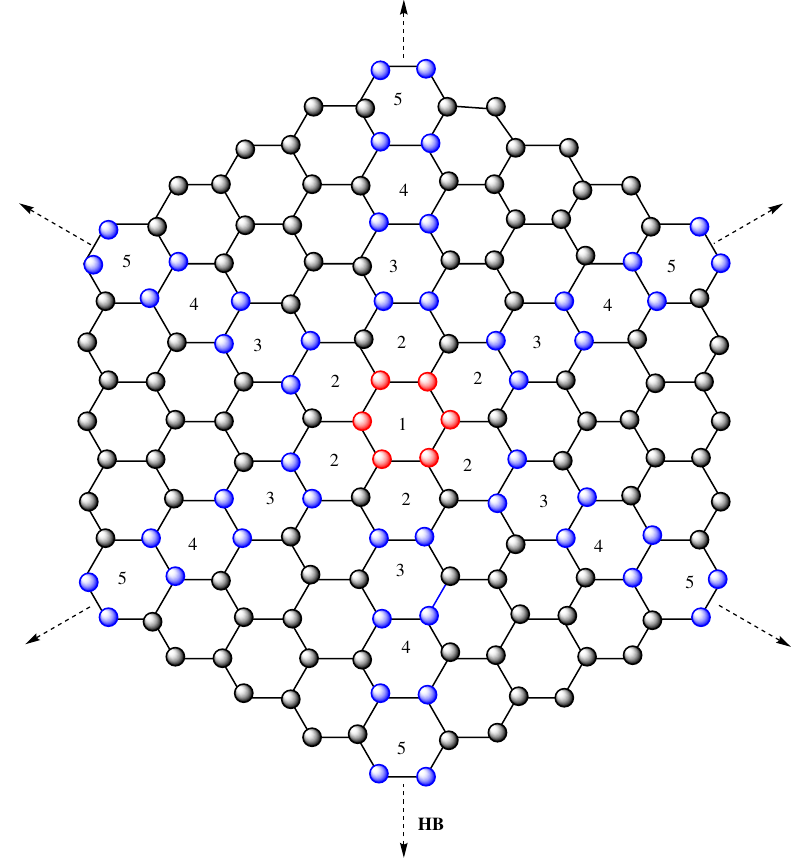
Figure 5. The honeycomb benzenoid